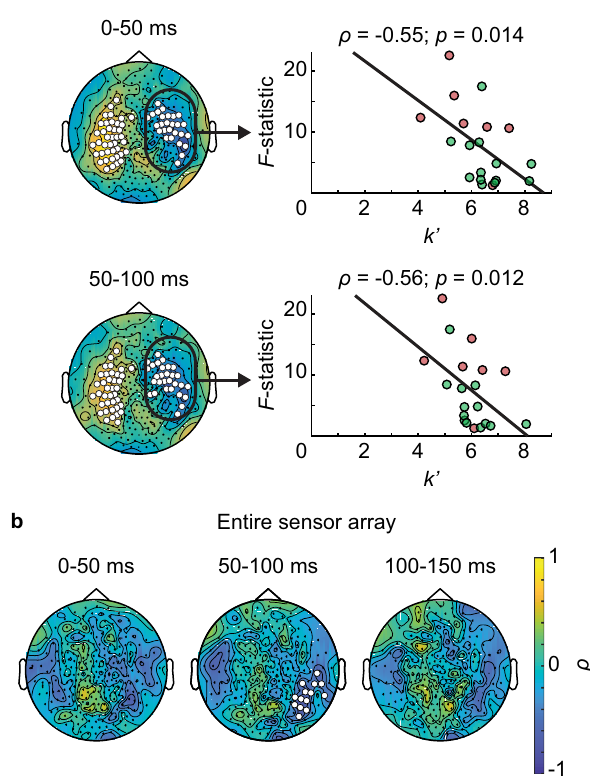
Fig. 6 Number of neurally integrated tones correlates with behavioral indices of sensory history dependence across subjects ( n = 20 participants). a Across-subject Spearman correlation of the number of preceding tones best explaining neuromagnetic activity ( k 0